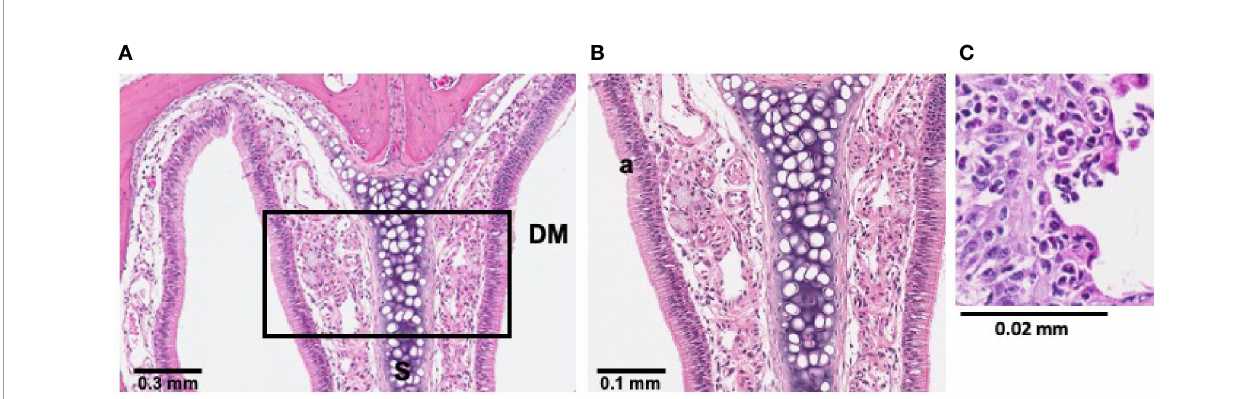
FIGURE 6 | LESB65-mediated in fl ammation was maintained in sinonasal mucosa for 5 days. P. aeruginosa LESB65 was inoculated dropwise into the left naris of C57Bl/6 mice (~10 6 CFU). Histological sections treated with hematoxylin and eosin (H&E) stain revealed that sinonasal mucosa with neutrophilic in fl ammation was maintained 5 days post-infection. (A) Immune cell in fi ltration was observed at a 4 mm deep cross-section of the nasal cavity. (B, C) Select areas of the fi eld were expanded to enable visualization increased neutrophil in fi ltration